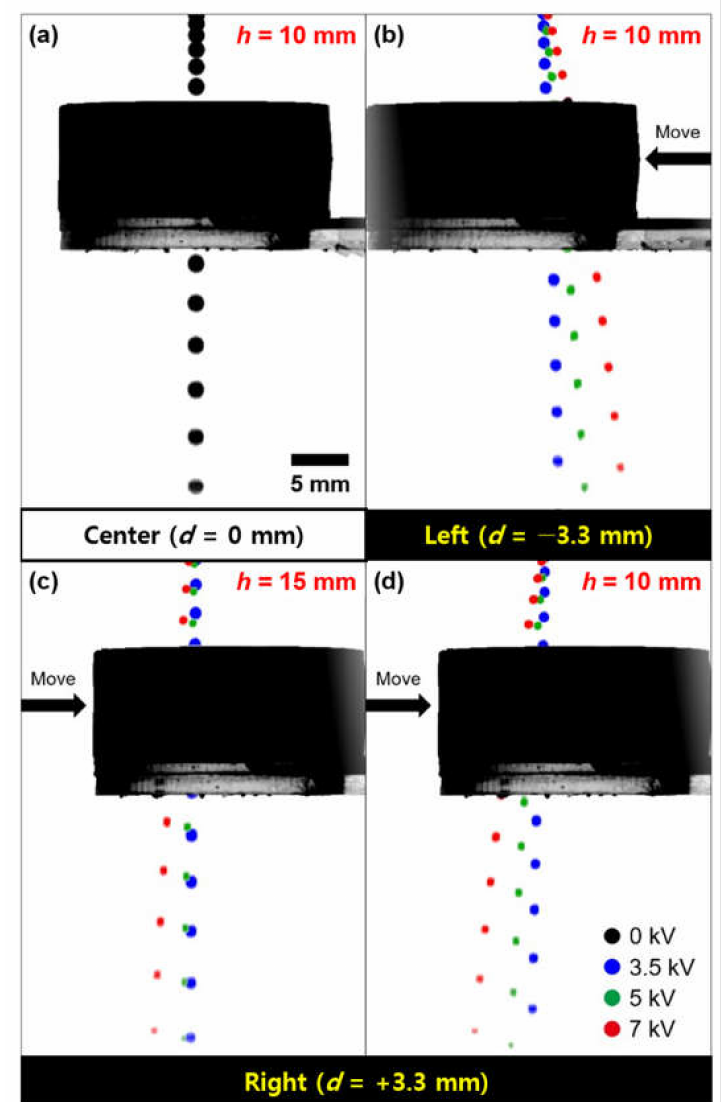
Figure 7. Superimposed sequences for the on-demand direction manipulation of the falling gallium- based liquid metal droplet by applying various voltages (0, 3.5, 5, and 7 kV) according to a position of the ring-shaped Cu electrode (multimedia view): ( a ) falling of droplet in the center direction at h = 10 mm; ( b ) falling of droplet in the left direction at h = 10 mm; falling of droplet in the right direction at ( c ) h = 15 mm and ( d ) h = 10